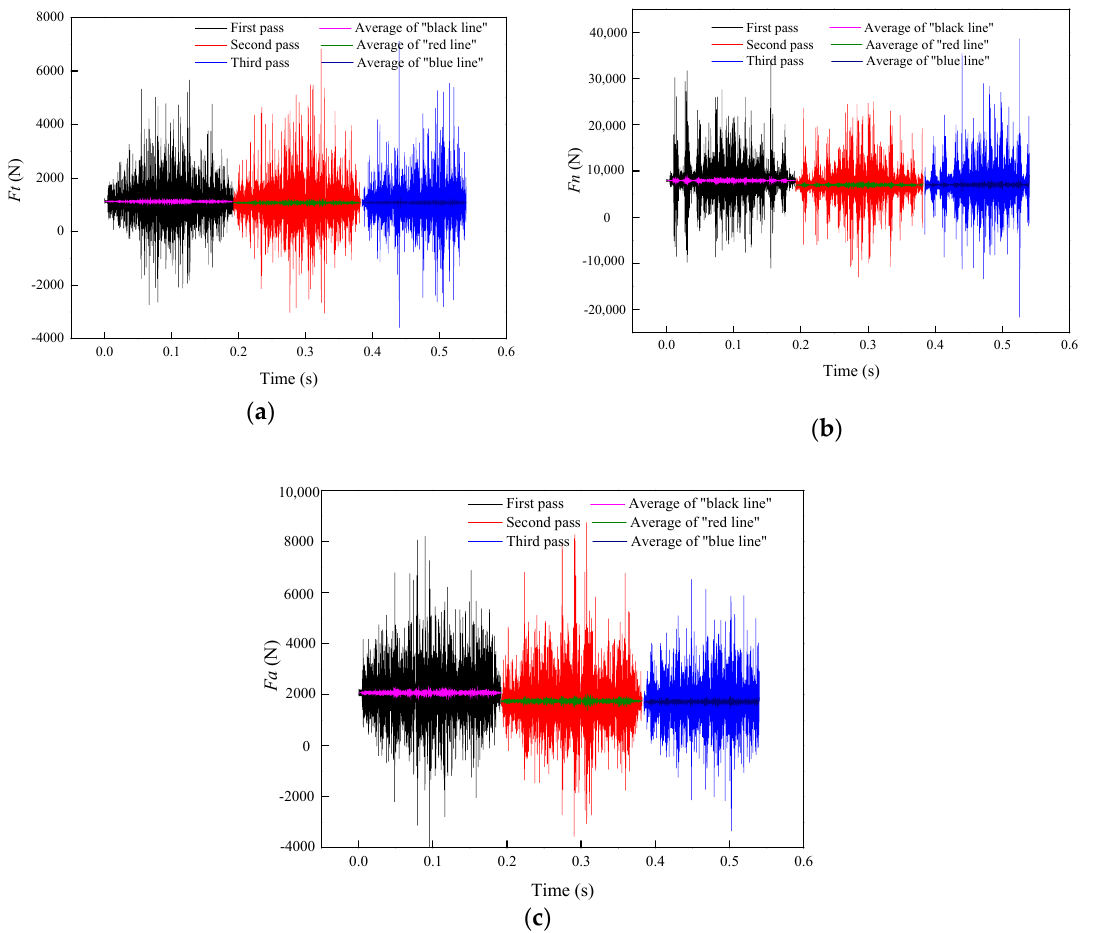
Figure 13. Change in the grinding force with the number of grinding passes: ( a ) F t ; ( b ) F n ; and ( c ) F a .